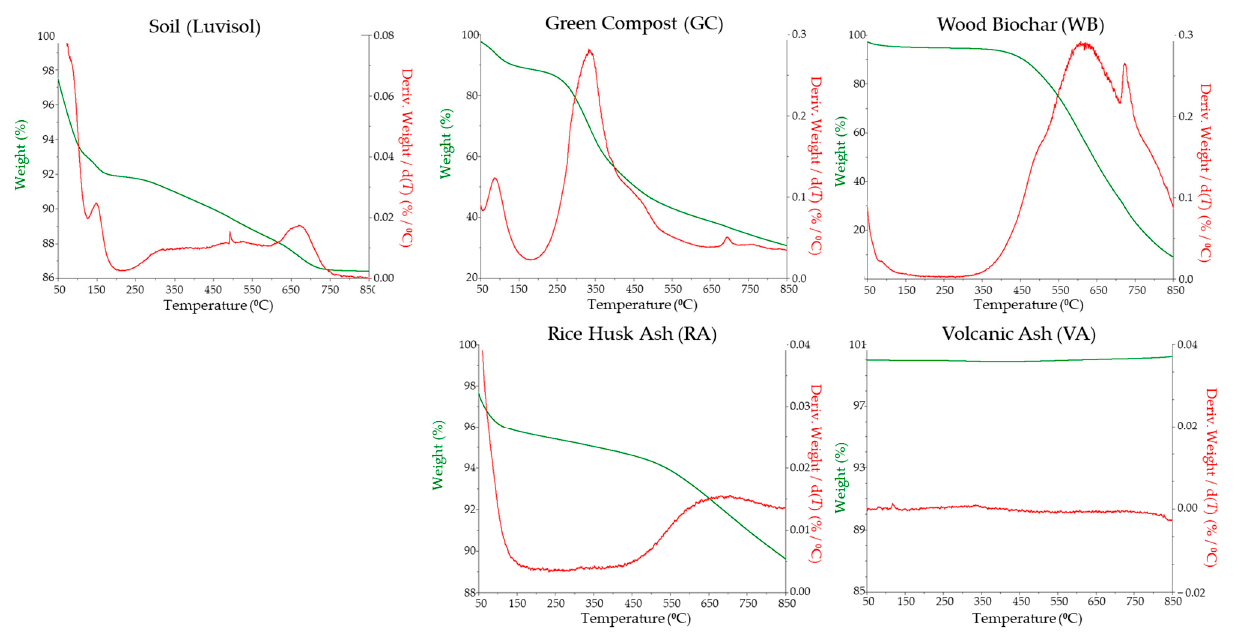
Figure 1. Thermo-gravimetric (TG) and derivative of thermo-gravimetric (DTG) curves of soil and amendments. Green lines are TGs, red lines are DTGs.